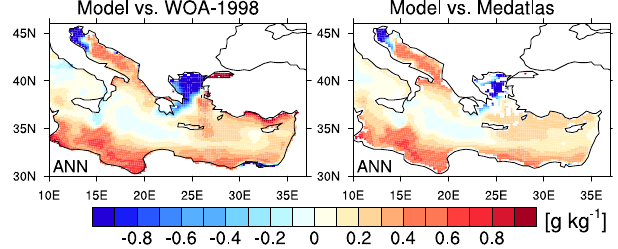
Fig. 6. Annual mean SSS deviations at 6m depth. CTRL vs. World Ocean Atlas 1998 climatology (left) and CTRL vs. MEDATLAS climatology (right) are represented.